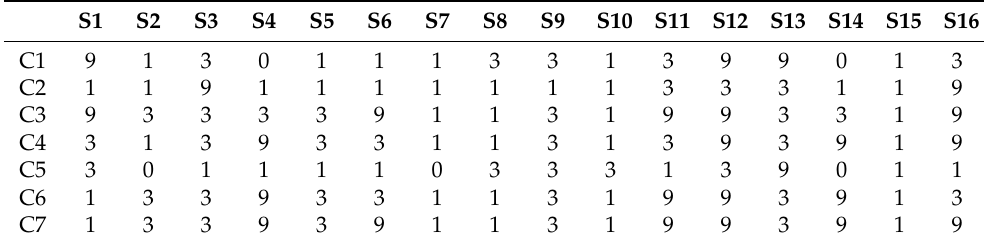
are shared in Table 3. In this table, symbols used for stages are ( S 1 , S 2 , . . . , etc.) and for constraints are ( C 1 , C 2 , . . . , etc.). Values in the matrix have the same meaning as for the case of the matrix from Table 1. Table 3. The second connection matrix describes how relevant each constraint is for all 16 stages. S1 S2